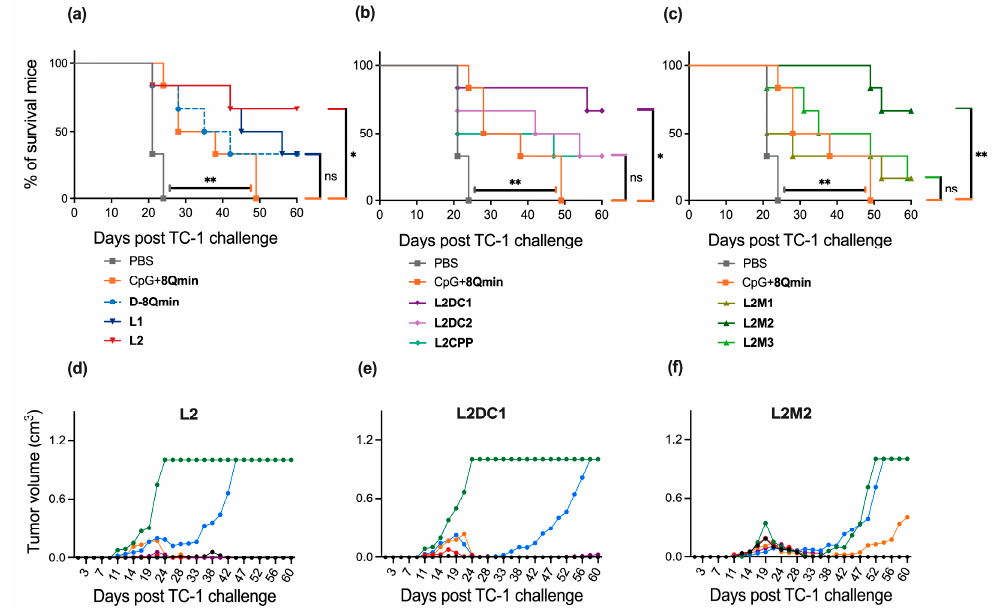
Figure 3. In vivo tumor treatment experiments. C57BL/6 mice (n = 6 mice/group) were inoculated subcutaneously with TC-1 tumor cells (day 0) and vaccinated with different immunogens on day 11. ( a – c ) Survival rate was monitored and time to death plotted on a Kaplan–Meier survival curve (separated here into three panels for clarity). The survival rate of each group was compared with the positive control (CpG + 8Qm ) and was analyzed using the log-rank (Mantel–Cox) test (ns, p > 0.05; *, p < 0.05; ** p < 0.01). Tumor volume was monitored and plotted for each individual mouse immunized with ( d ) L2 ; ( e ) L2DC1 ; ( f ) L2M2 . Tumor volume charts for other groups are presented in Supporting Information, Figure S7.